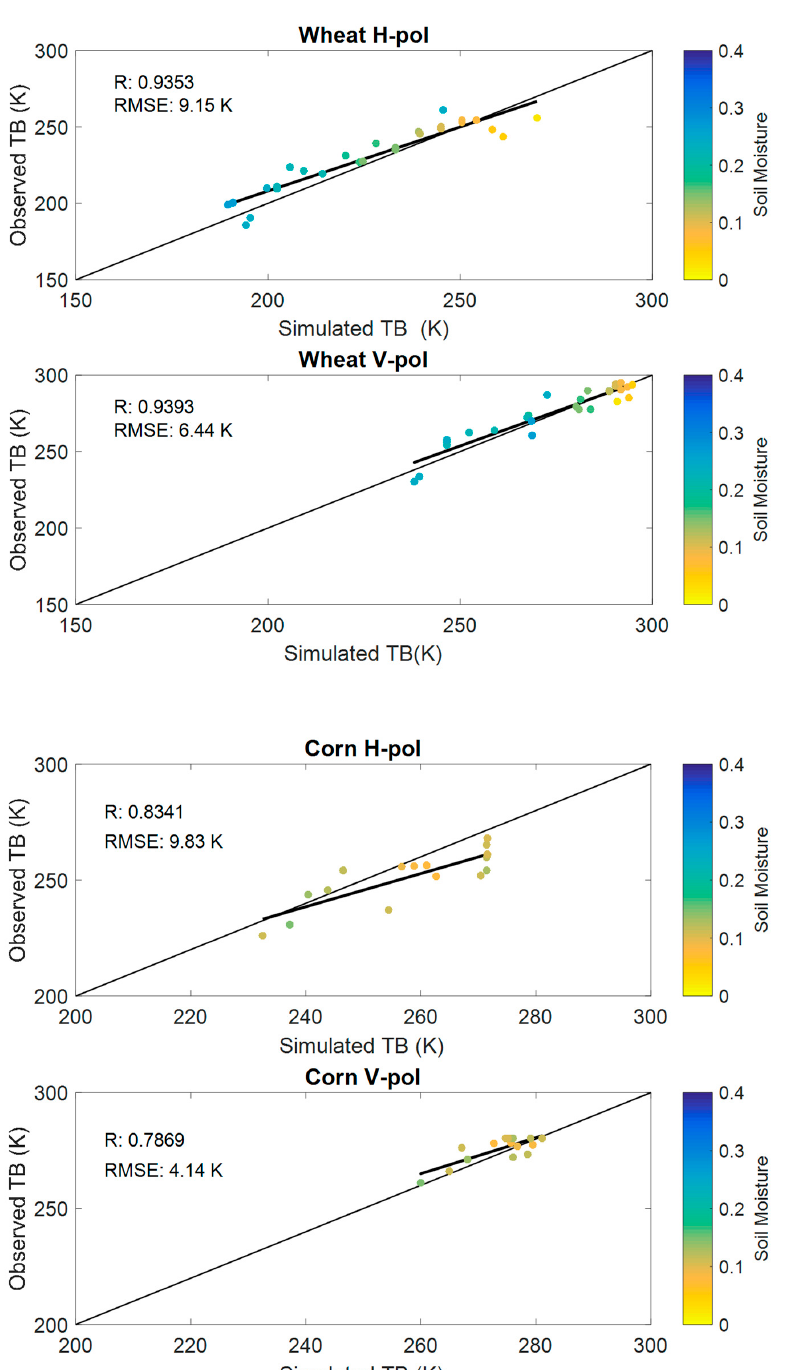
Figure 3. Comparison between radiometer measured and Tor Vergata model simulated brightness temperature of wheat and corn at L band in V and H pol. (top: wheat, bottom: corn).